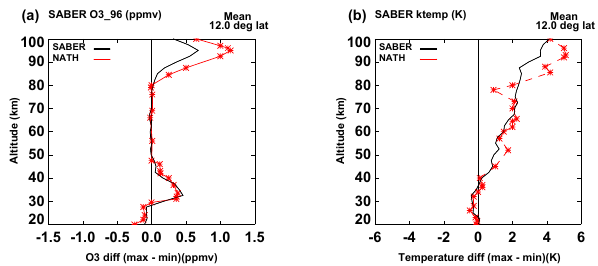
Figure 5. Ozone (left) and temperature (right) responses to solar activity vs. altitude, from 20 to 100km. Values are responses at solar max − responses at solar min in ppmv(100sfu) − 1 for ozone and K(100sfu) − 1 for temperature. Black lines denote SABER re- sponses at 12 ◦ lat; red color denotes results of Nath and Sridha- ran (2014), for 10–15 ◦ lat, also based on SABER data.